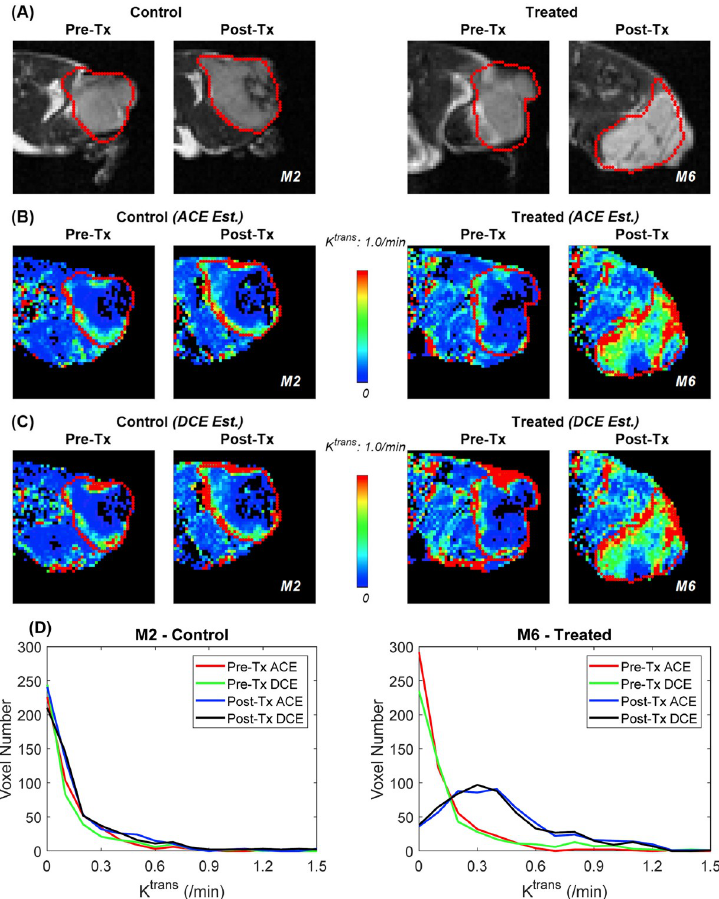
Fig 2. Representative T weighted tumor images (a) for control group (mouse M2) and treatment group (M6) at pre- 2 treatment (Pre-Tx) and post-treatment (Post-Tx). K trans maps of the control group (mouse M2) and treatment group (M6) using the ACE-MRI method (b) and conventional DCE-MRI method (c) at Pre-Tx and Post-Tx scans. Red ROI indicates tumor lesions. (d) Histograms of estimated K trans values of voxels in the tumors shown in (b) and (c) for M2 and